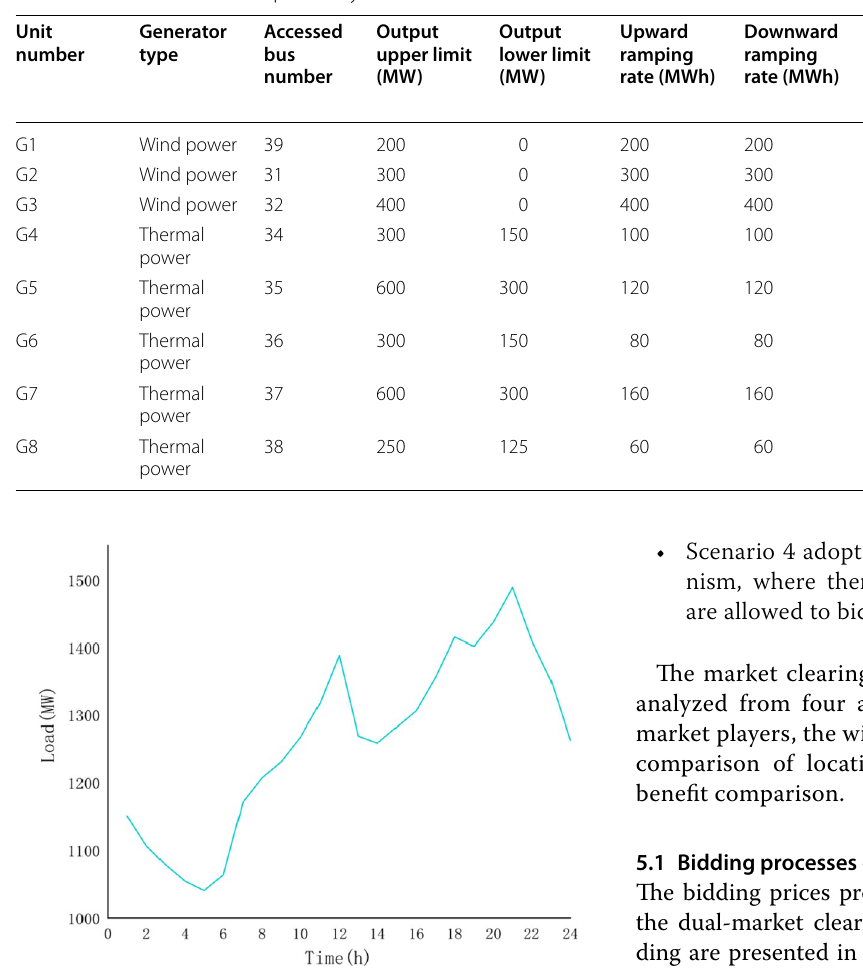
Fig. 7 Total load curve applied over a 24-h